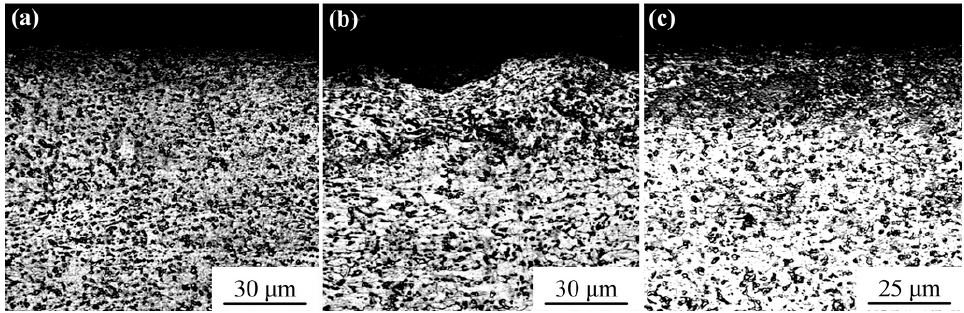
Figure 15. Profile morphologies of UIRP samples at ( a ) 250 r/min, ( b ) 478 r/min and ( c ) 637 r/min.